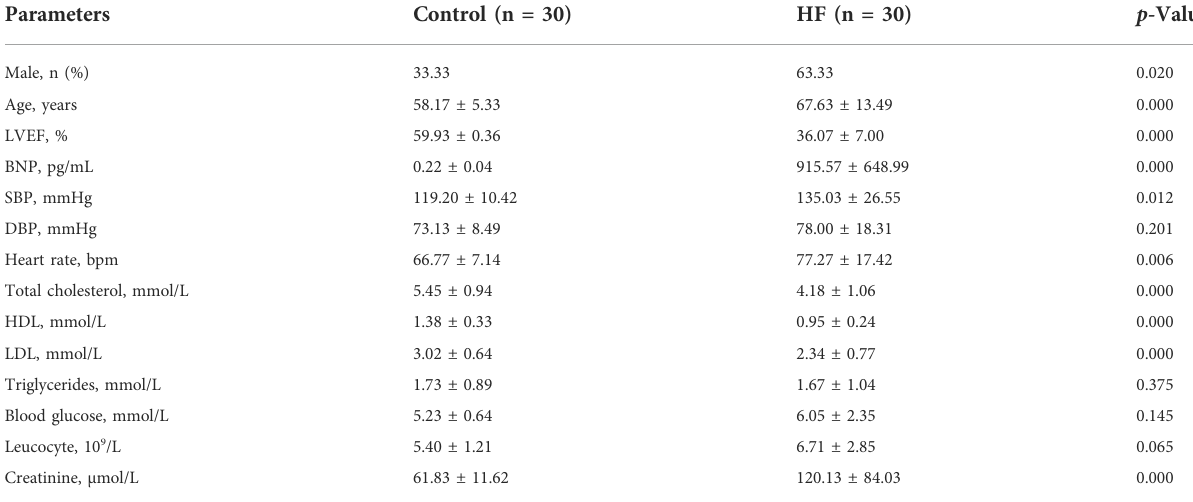
TABLE 2 Baseline characteristics of patients with heart failure (HF) or control subjects.